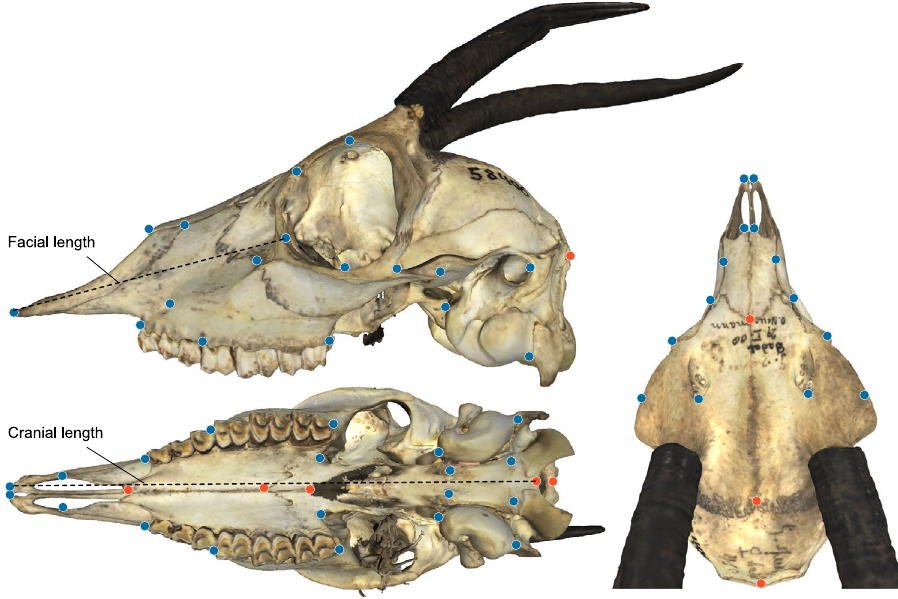
Fig. 8 Landmarks used in this study, The 53 cranial landmarks are shown on a 3D surface model of a female Gazella spekei (ZMB Mam 58406). Bilateral landmarks in blue, midline in red. Shown also are the two distances measured to calculate the facial length Method of 3D model acquisition . Since different scanning devices can introduce a bias 48 , shape differences between specimens generated using different scan types (Artec vs. CT) were assessed using ordinary least squares ANOVA. Only specimens belonging to species scanned with both scan types were included ( n = 50). Phylogenetic and taxonomic differences . In order to examine the effects of phylogenetic inertia on cranial shape, phylogenetic signal in the Procrustes shape coordinates was measured using the multivariate version of Blomberg ’ s K 49,50 , for which values close to zero indicate weak or no phylogenetic signal (close relatives less similar than expected by chance), values around 1 are consistent with con- served signal and morphological evolution through Brownian motion, and values greater than 1 indicate strong phylogenetic divergence (i.e., close relatives are more similar than expected by chance). All analyses that took phylogeny into the account used a pruned version of the mammal tree of Faurby and Svenning 51,52 , which is based on genetic data. In order to compare morphospace occupation between subfamilies and among tribes, differences in shape were examined using ordinary least squares (ols) ANOVA with random permutation. Disparity and rates of evolution of shape were examined using phylogenetic generalized least squares (pgls) ANOVA with random permutation. Disparity was calculated as the Pro- crustes variance. Rates of shape evolution were calculated from the Procrustes shape coordinates along a phylogeny and under a Brownian motion model.